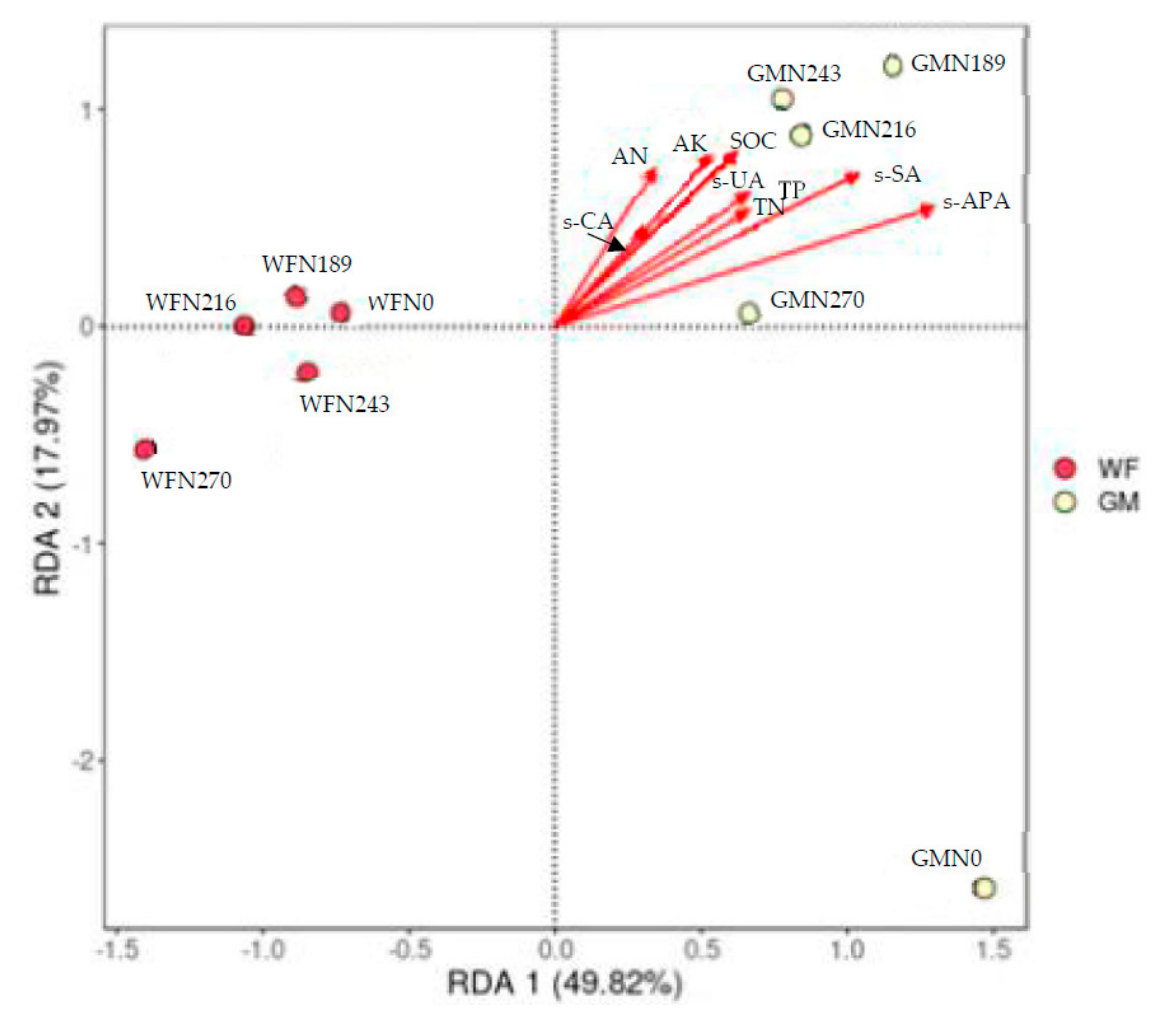
Figure 8. RDA analysis of soil microbial community structures and environmental factors. The red arrow line length represents the affect strength of environmental factors on soil microbial community structures SOC, soil organic carbon; TN, total nitrogen; TP: total phosphorus; AN, available nitrogen; AK: available potassium; s-CA, soil catalase activities; s-SA, soil sucrase activity; s-UA, soil uease activity; s ‐ APA, soil alkaline phosphatase activity.